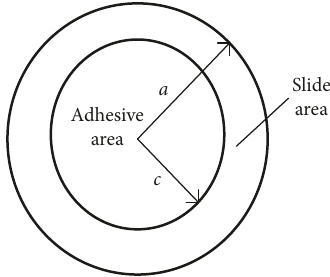
Figure 3: Division of the adhesive and slide areas in the contact surface.